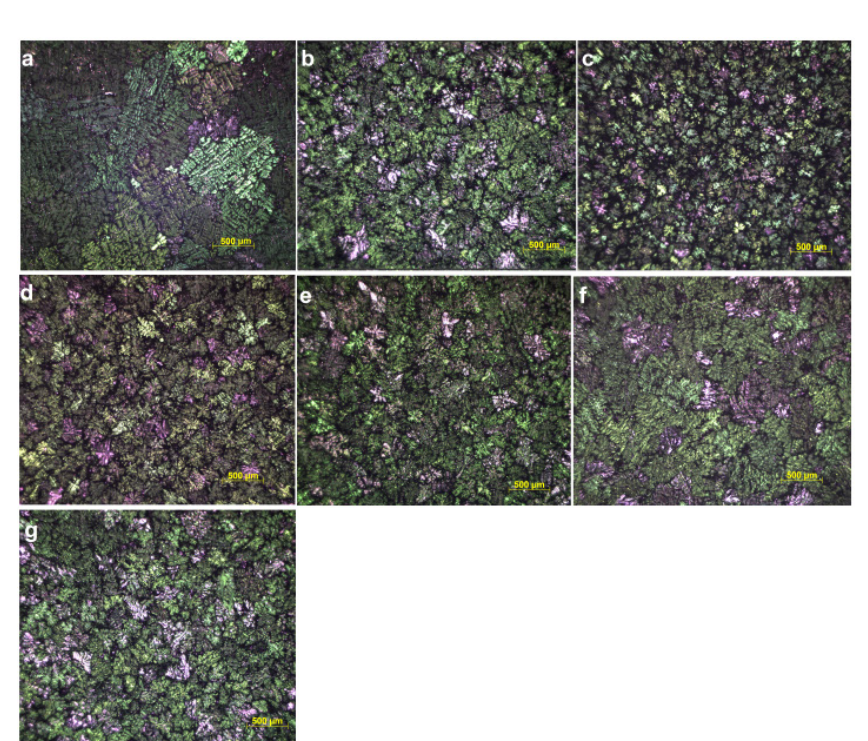
Figure 5. Al7Si1Fe”X”NbB alloy, where: a) X=0%. b) X=0.02%. c) X=0.05%. d) X=0.1%. e) X=0.2%. f) X=0.5%. g) X=1%.